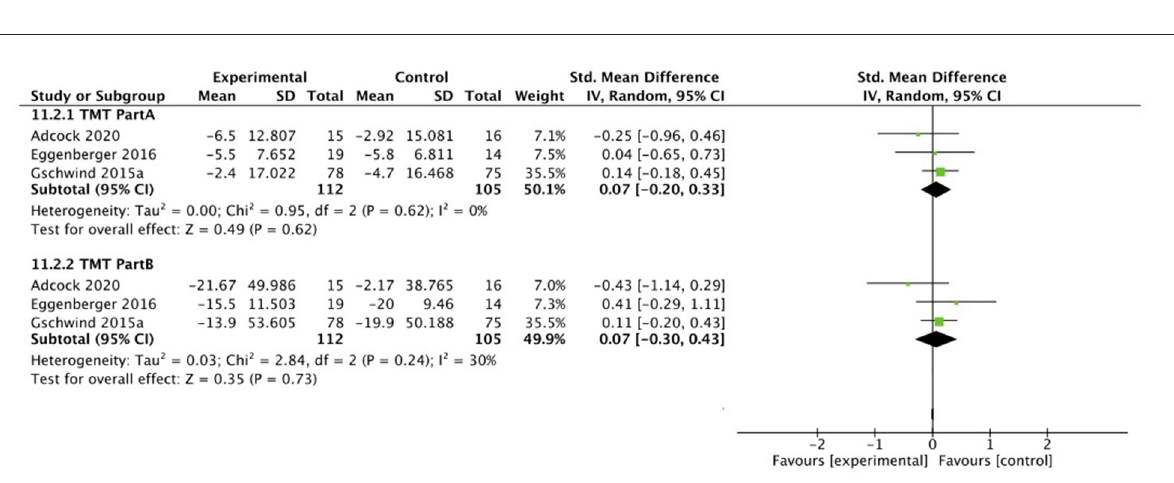
FIGURE12 Random effects meta-analysis forest plot for effectiveness of intervention on measures of TMT cognitive performance